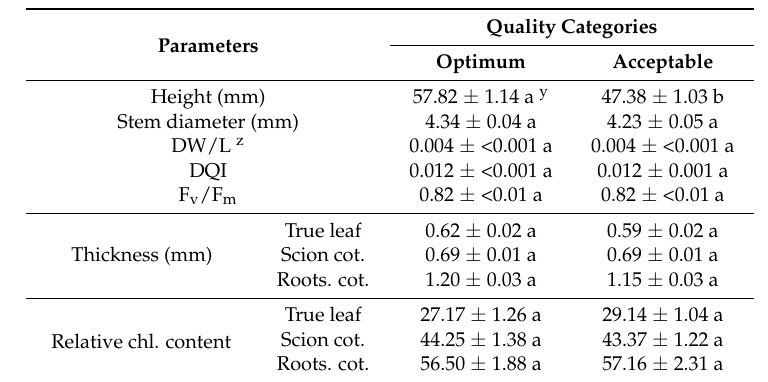
Table 2. Morphological and developmental parameters of grafted watermelon seedlings from two quality categories 7 days after grafting.